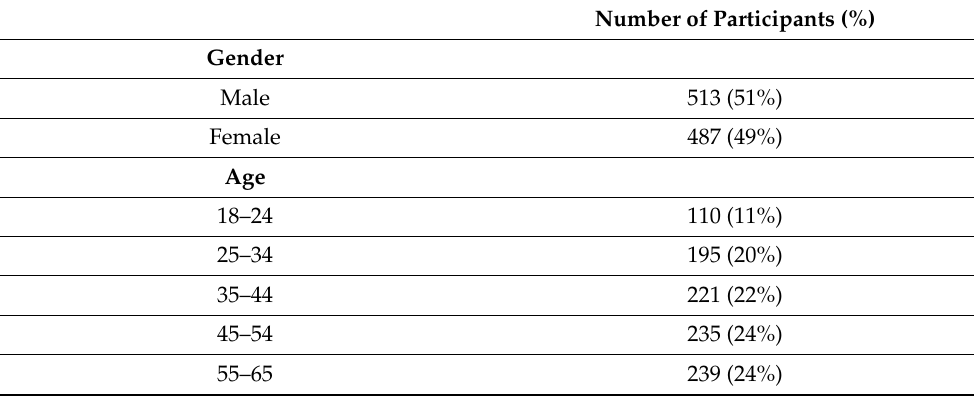
Table 1. Sociodemographic and lifestyle characteristics of